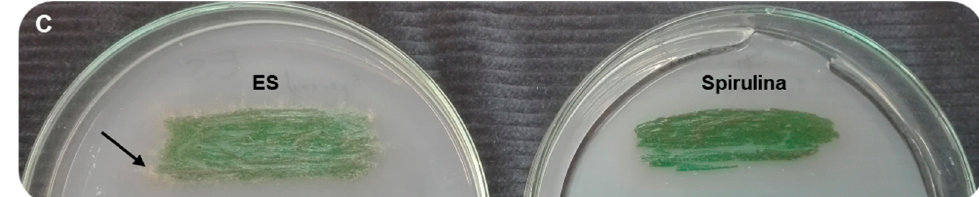
Figure 1. The fungal strain AGSC12 from the culture broth of the cyanobacterium SAG 88.79. ( A ) The isolated strain AGSC12 on EMMA slant agar and in EMML liquid medium. ( B ) The presence of the AGSC12 strain in SAG 88.79 culture broth after photobleaching the cyanobacterial cells in Spirulina medium. ( C ) Fungal hyphae among the cyanobacterial colonies and at the edges of the colonies on ES and Spirulina media containing plates. On ES medium, the fungal growth was stronger, and on Spirulina medium, the fungal presence was indicated by the brownish tone on the top of the cyanobacterial colony. ( D , E ) Microscopic images of the fungal hyphae among the cyanobacterial cells. ( D ): Nomarski microscopy. ( E ): phase-contrast microscopy. Scale bars = 20 µm .